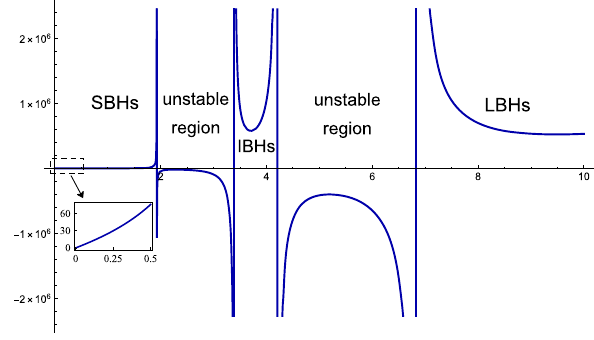
Fig. 12 Four divergence points and small/intermediate/large black versus r + for k = 1, i hole (SBH/IBH/LBH) phase transition: C P , X versus r + for k = 1, i d = 7, P (cid:5) 1 . 09, q = 0, m (cid:5) 5 . 98, c 0 = 1, c 1 (cid:5) − 3 . 98, c 2 (cid:5) 12 . 8, c 3 (cid:5) − 12 . 02, c 4 = 13 . 63 and α (cid:5) 9 . 08. In order to observe the